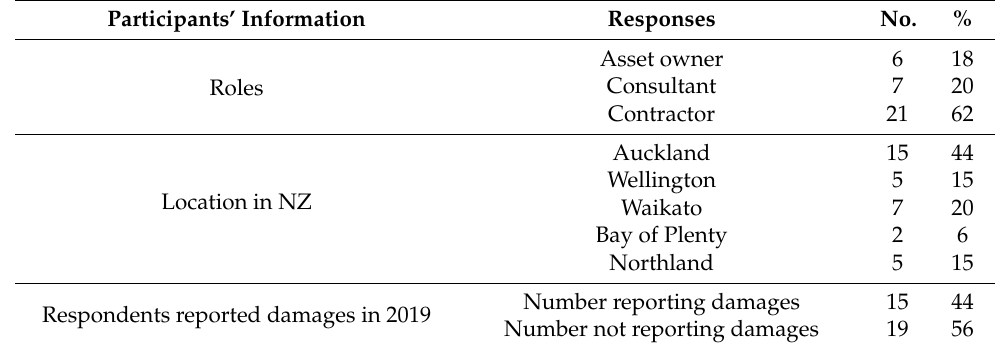
Table 1. Participants demographics.